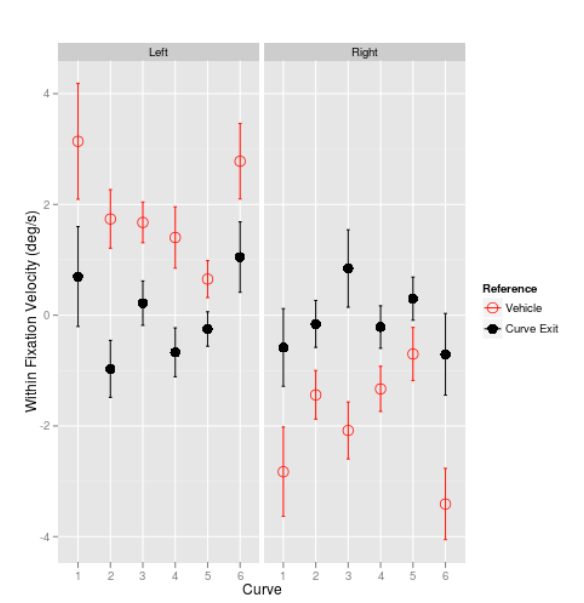
Figure 3. Within-fixation mean rotational velocity of the eye during (deg/s), in the vehicle frame of reference (red) and a frame of reference rotating along with the apparent motion of the curve exit point (black). Data averaged across eighteen subjects, error bars 95% CI. Positive is to the left. Left panel: turning left (westward leg), right panel: turning right (eastward